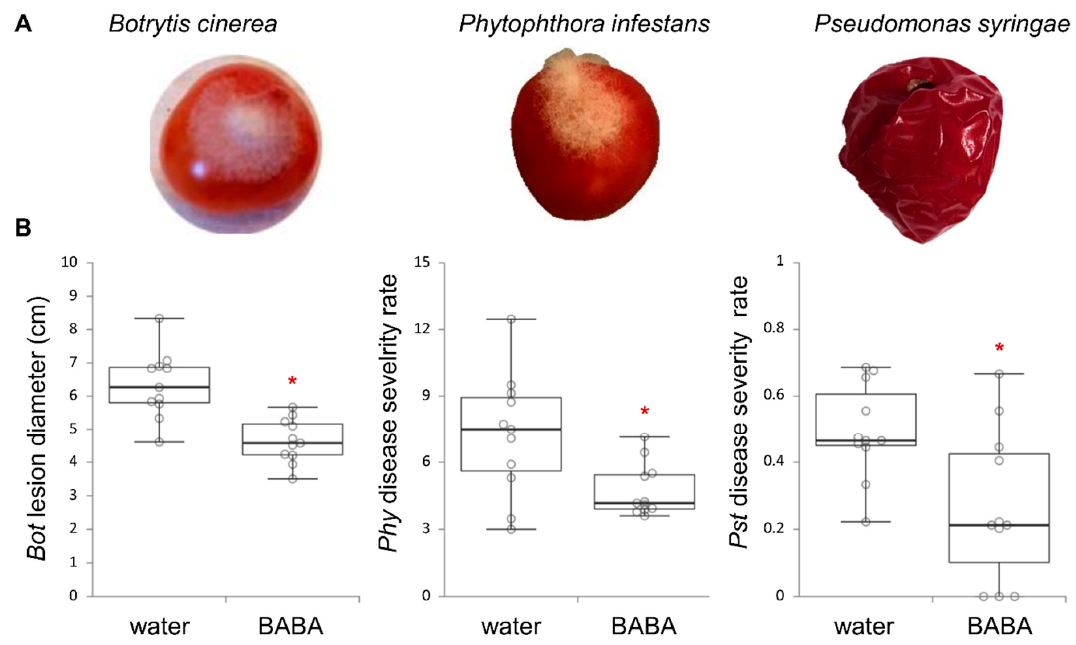
Figure 1. ß-aminobutyric acid (BABA) primes tomato fruit for a durable disease resistance against three different pathogenic microbes. ( A ) photographs showing tomato fruit 2 days after infection with Botrytis cinerea ( Bot , left), Phytophthora infestans ( Phy , middle) or Pseudomonas syringae pv. tomato ( Pst , right). ( B ) box-plots of disease symptoms from fruit that originated from plants treated with water or BABA (500 µM) then inoculated with water as a mock control or with Bot (left), Phy (middle) and Pst (right). Symptoms were scored 2 days after inoculation from 11 biologically replicated fruit ( n = 11). Asterisks indicate statistically significant differences between water- and BABA-treated plants (t- test, P < 0.01).